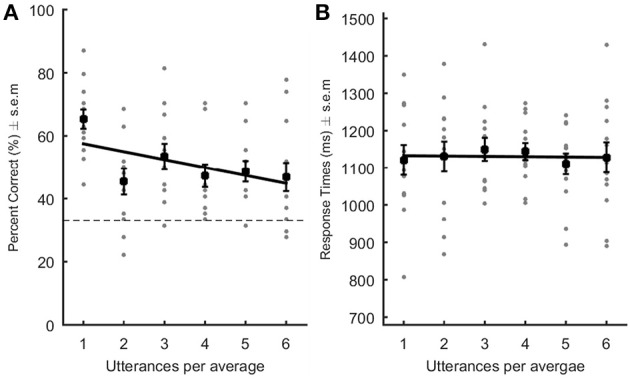
Performance in the recognition of trained-to-familiar voices. Percent correct (A) and response times (B; ms) are represented as a function of the level of averageness (i.e., number of utterances per voice average). Gray dots represent each participant's data point. The black square represents the average performance across listeners. In (A), the dotted line indicates chance level. Black lines: linear regression built using the average slope and intercept values obtained after performing the linear regression in each subject. The slope was significantly decreasing in (A) indicating that performance worsened with increasing number of utterances per average.